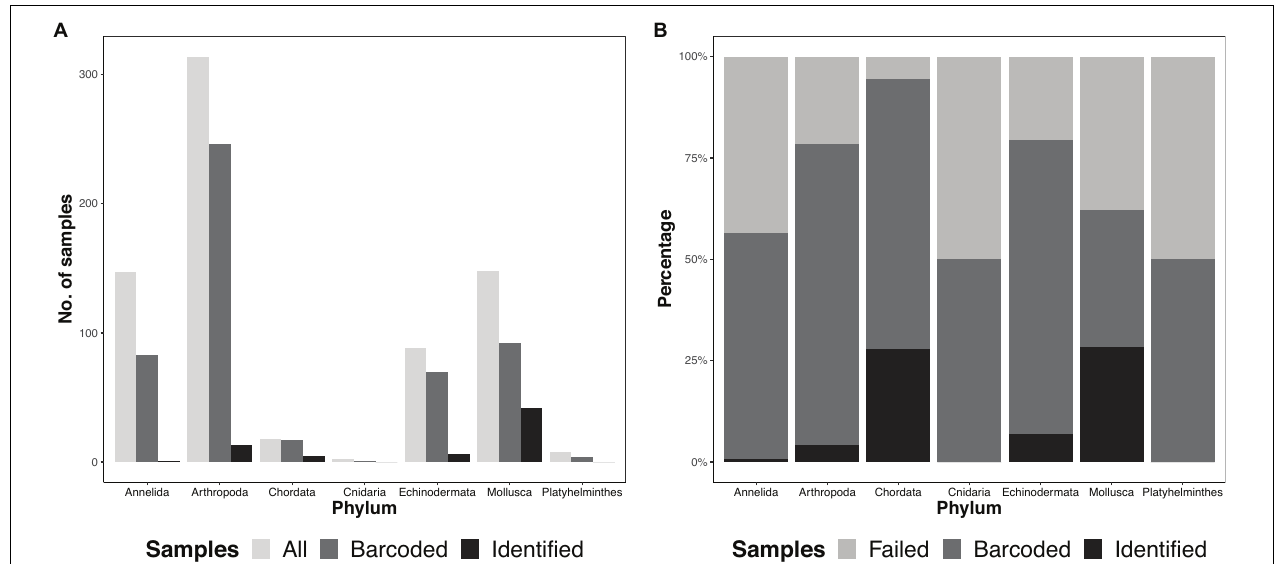
FIGURE 2 | Total diversity obtained from ARMS across the different phyla (A) by abundance, showing the total number of samples obtained (“All”), number of barcodes obtained at the consolidated stage, namino = 1 setting (“Barcoded”), and number of consolidated barcodes with species-level identification at ≥ 97% (“Identified”), and (B) by proportion, showing “Barcoded,” “Identified” and samples that did not amplify